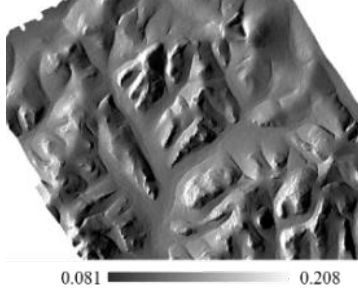
Figure 3. Vertical wave number